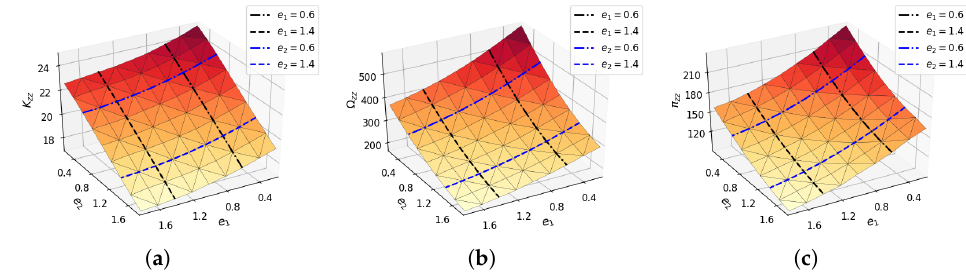
Figure 7. Tensor component values are presented with respect to e 1 and e 2 , for the examples of tensor components K zz , Ω zz and Π zz , shown at ( a – c ) sections respectively. Parameters λ 1 and λ 2 are fixed to the values of 5 and 3. Black and blue dotted lines are displaying the one-dimensional fit functions, which are positioned at the fixed values of e 1 and e 2 as indicated in the plot